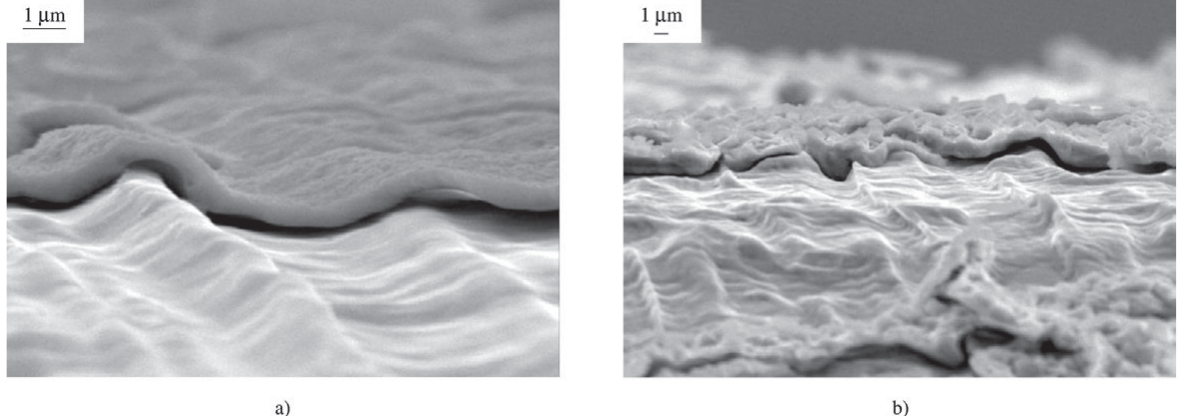
Figure 10. Surface of the Fe-18Cr steel grade observed after removing the oxide scale by bending samples oxidised at 900 °C (left : in water vapour, right: in oxygen).